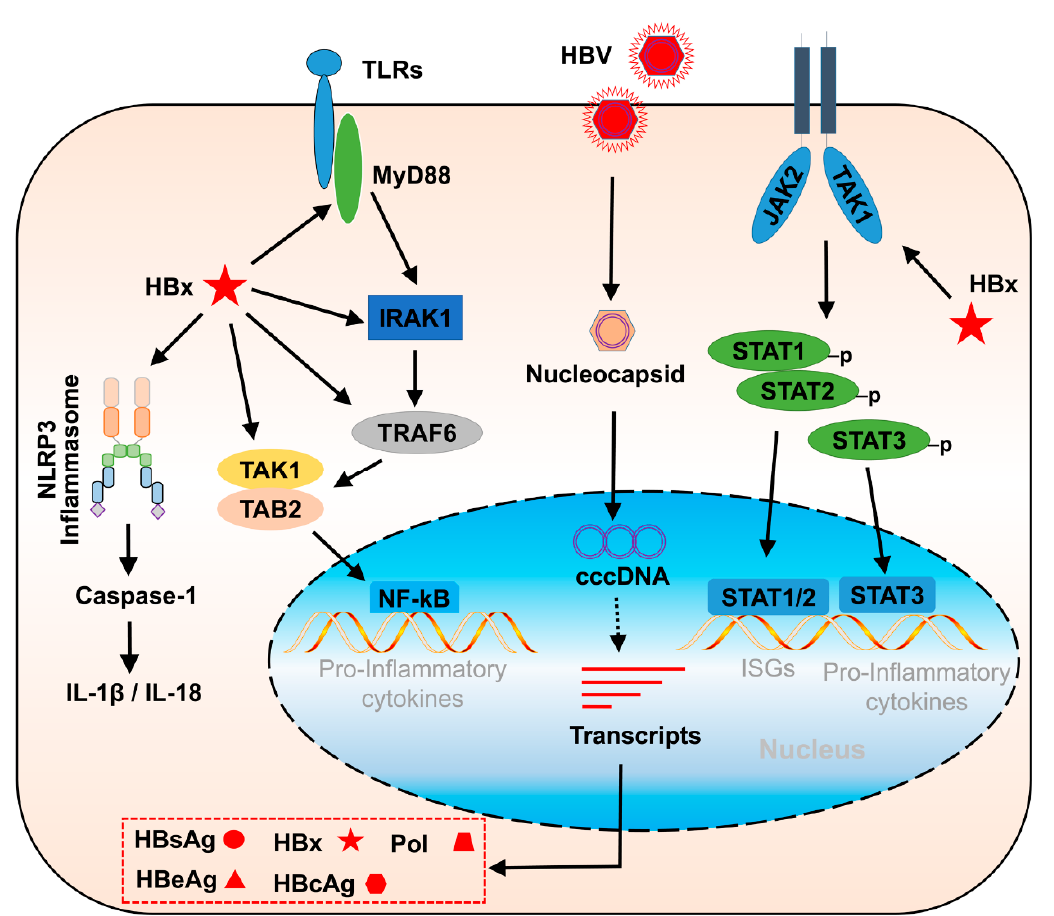
Figure 1. The promoting roles of Hepatitis B virus x protein (HBx) in the signal transduction of innate immunity and inflammation in HBV infection. HBx can activate TLR and nuclear factor-kappaB (NF- κ B) signal pathways which promotes the expression of pro-inflammatory cytokines. HBx interacts with Janus Kinase 1 (JAK1), promoting the signal transducer and activator of transcription 1/2 (STAT1/2)-mediated ISG expression and STAT3-mediated cytokine expression. HBx promotes NLRP3 inflammasome activation to accelerate the release of IL-1 β and IL-18.